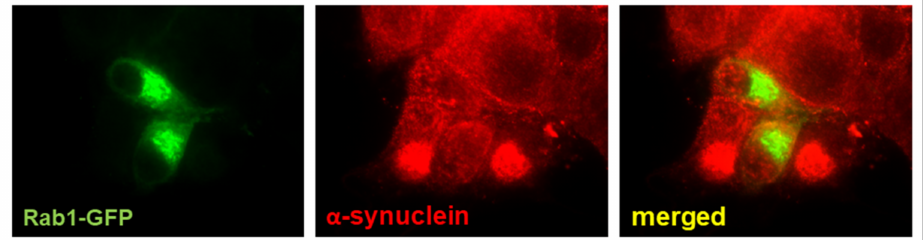
Figure 4. Rab1 overexpression reduces α -synuclein aggregates. These aggregates were induced in neuron-like differentiated PC12 cells by treatment with METH as a model of PD. Cells overexpressing Rab1-GFP have a reduced number of